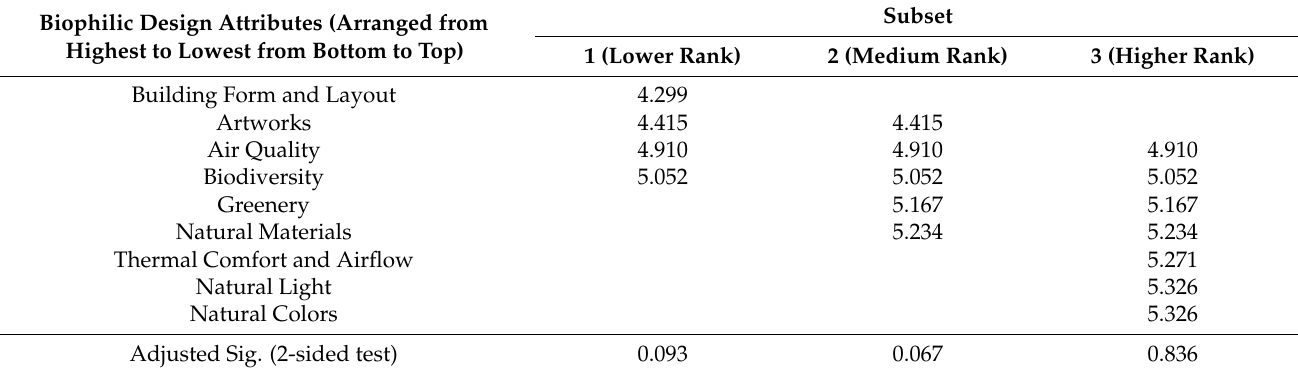
Table 11. Homogeneous subsets of biophilic design attributes for the workplace. Biophilic Design Attributes (Arranged from Highest to Lowest from Bottom to Top)